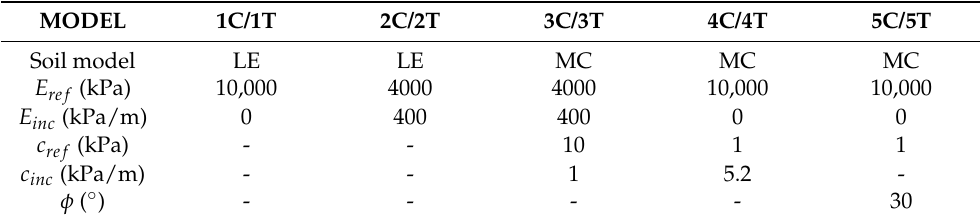
Table 2. Summary of soil and interface parameters in different FE models analyzed